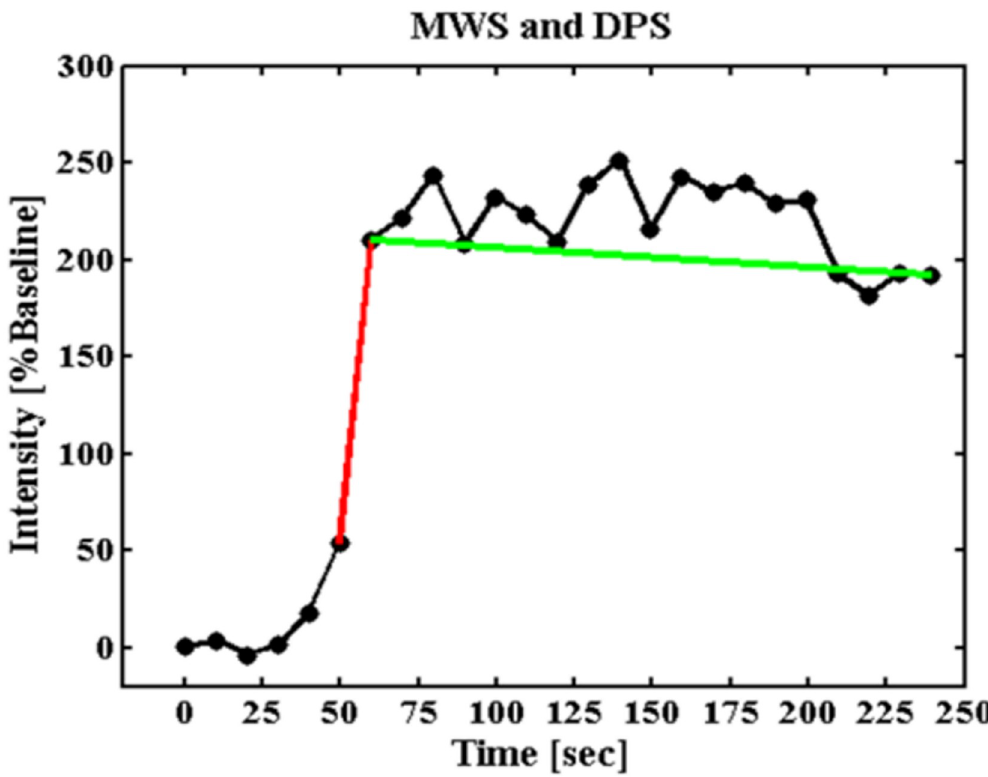
Fig 2. Maximum difference wash-in slope and a delay phase slope are shown during a time course from a single voxel. The wash-in slope (MWS, red line) and the delay phase slope (DPS, green line).